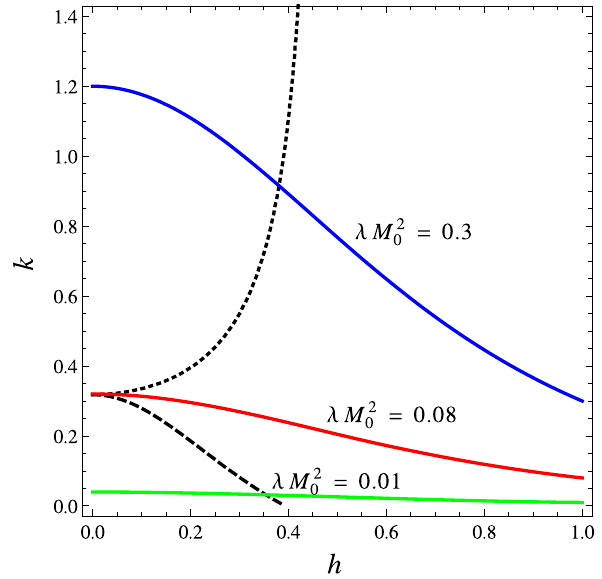
= 0 . 01 (green), λ M 2 0